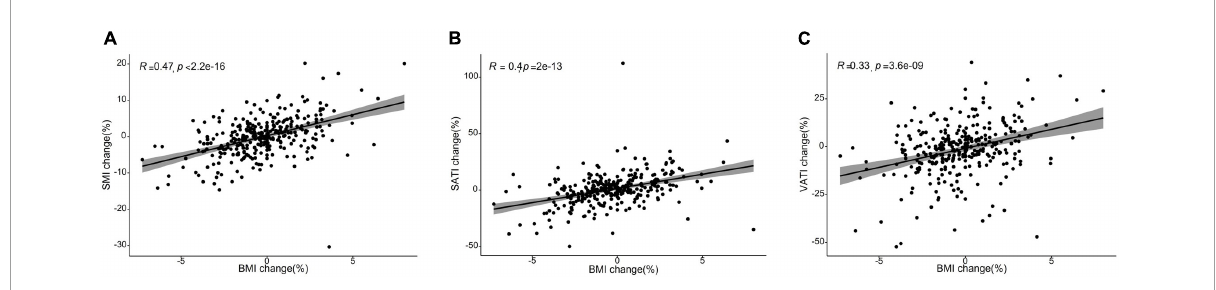
FIGURE1 Scatter plots showing a correlation between the changes in body mass index (BMI) and body composition parameters from baseline to 6 months after treatment completion. (A) Skeletal muscle index (SMI) changes were moderately correlated with changes in body mass index (BMI) ( R = 0.47, P < 0.001). (B) Subcutaneous adiposity index (SATI) changes were weakly correlated with changes in body mass index (BMI) ( R = 0.4, P < 0.001). (C) Visceral adiposity index (VATI) changes were weakly correlated with changes in body mass index (BMI) ( R = 0.33, P <